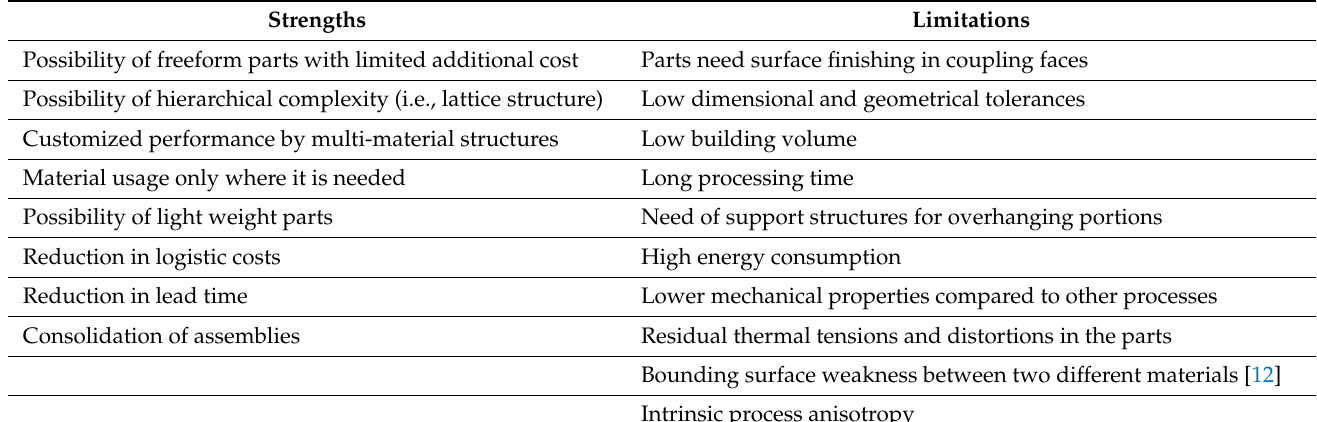
Table 1. Strengths and limitations of Additive Manufacturing (AM), on a general